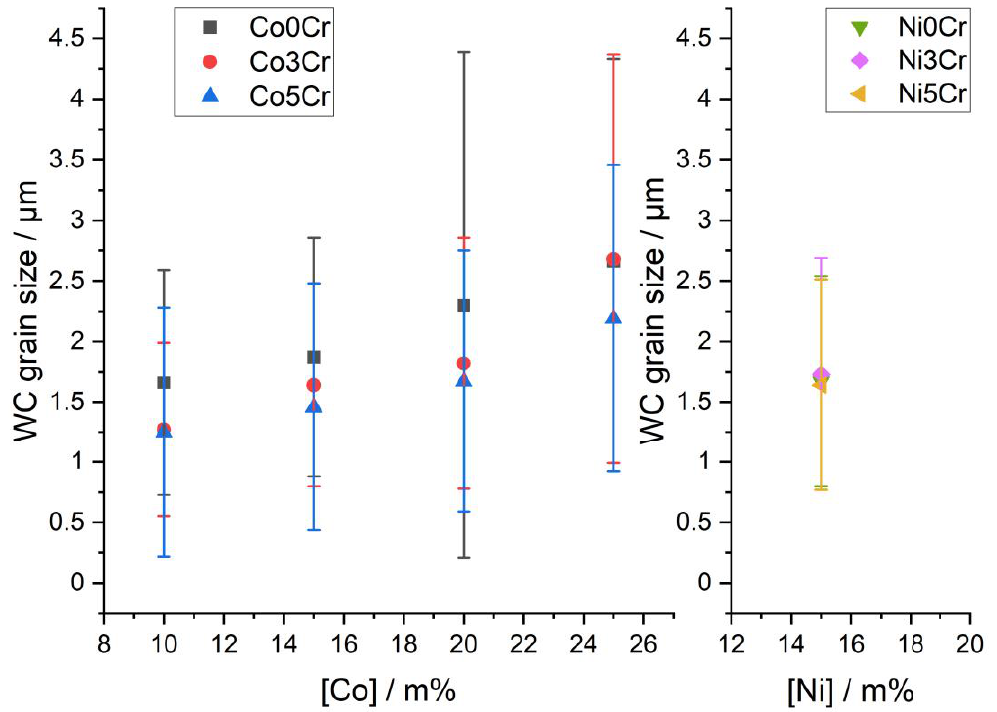
Figure 6. Mean WC grain size, evaluated by the linear intercept method [37]. For details of the samples, see Table 2.